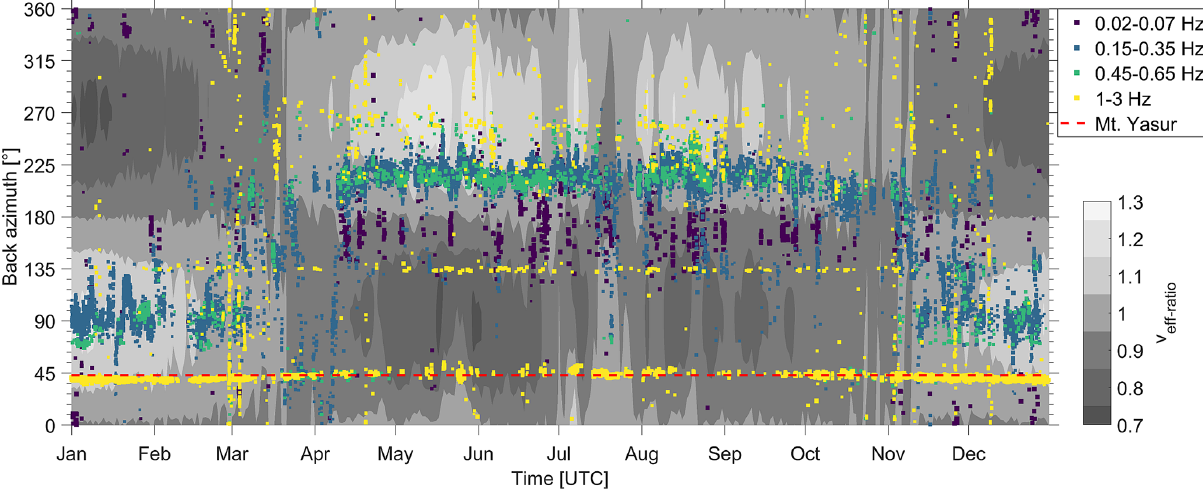
Figure 10. Back azimuth of IS22 data products (color-coded) in 2020, with the v eff-ratio (grayscale; analogous to Fig. 4) shown in the background. If the v eff-ratio is around or larger than 1, then arrivals from the corresponding direction are favorable in terms of the local propagation